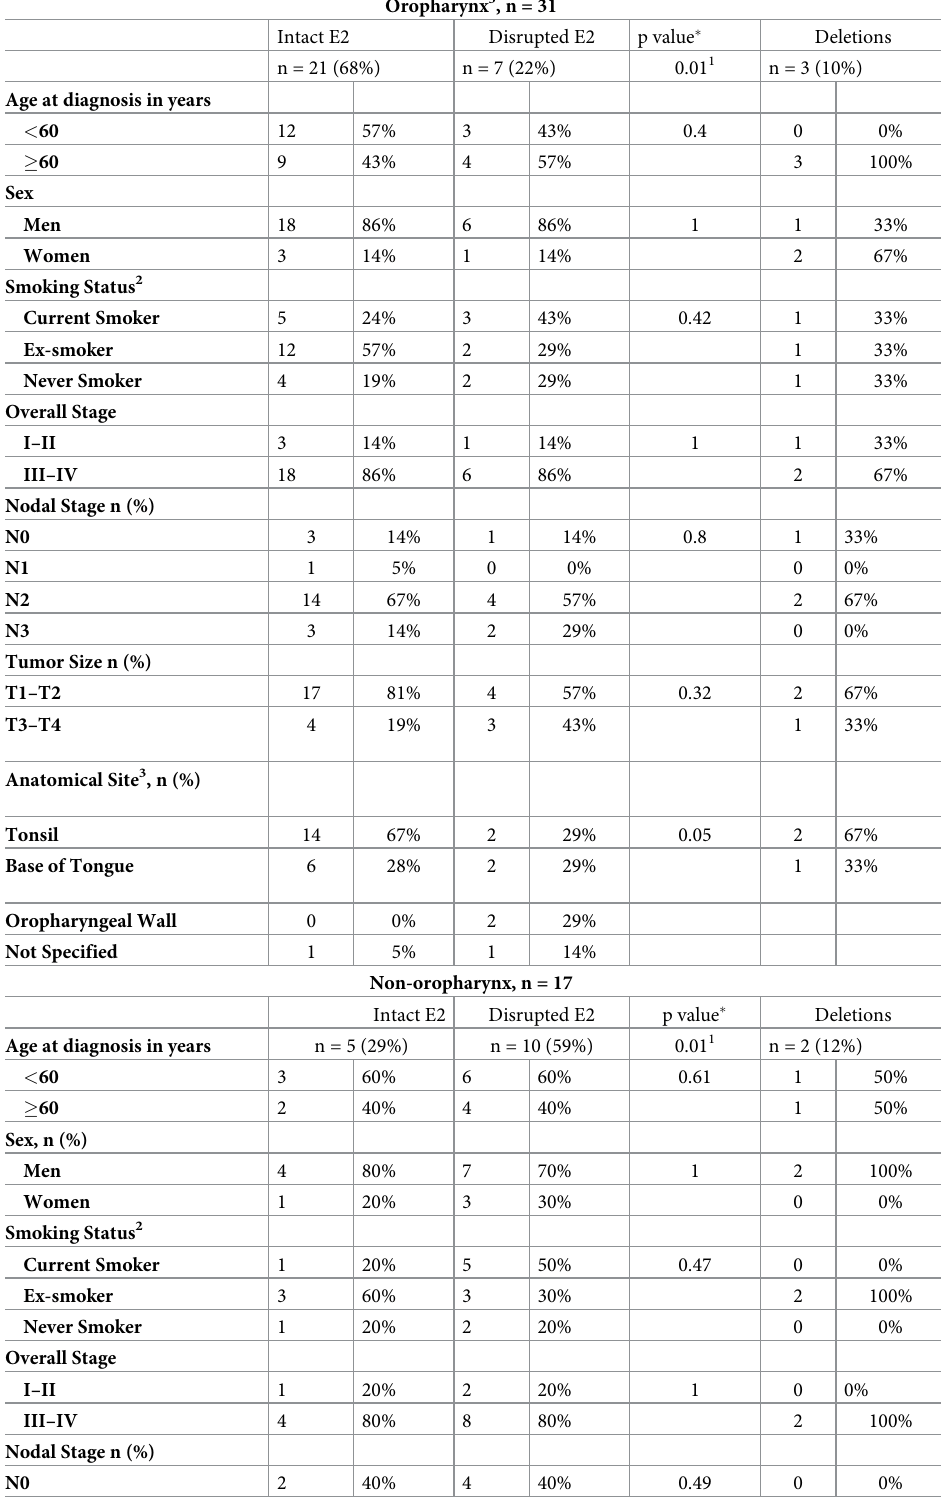
Table 1. Study population characteristics stratified by HPV16 E2 gene status and tumor